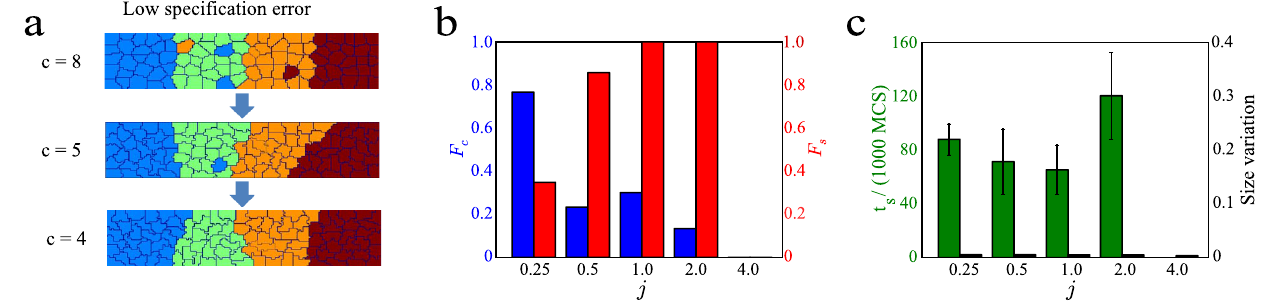
Figure 2. Differential adhesion model leads to low fraction of correct sorting but high fraction of stable sorting. 30 runs were performed for each value of j . ( a ) The cell grid at start (top), middle (middle) and end of a run (last). The number of clusters, c , is shown to the left of the grid. The parameter r ~ 0 : 025 is used to mimic a low cell fate specification rate. ( b ) Bar graphs of fraction of correct and stable sorting, F c (blue) and F s (red), respectively, for different values of magnitude of differential adhesion, j . For j = 4, none of the runs lead to correct sorting. ( c ) Bar graphs for sorting time, t s , (green) and size variation (black) for different values of j . Error bars show the standard errors.